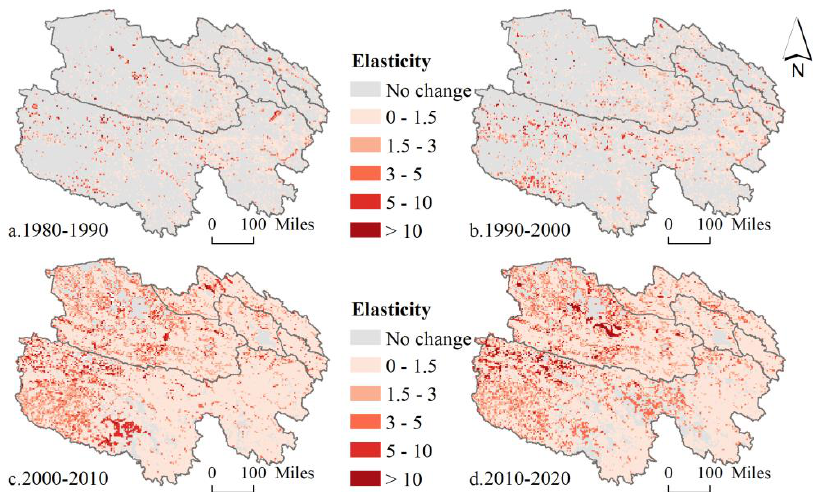
Figure 6. Elasticity of ESV changes in response to LUCC in Qinghai province during the periods